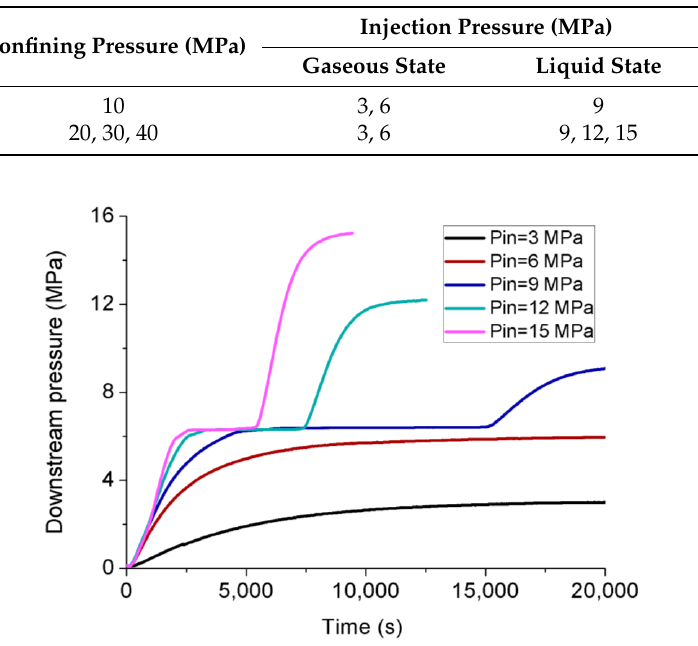
Figure 18. Measurement of downstream pressure at different CO 2 injection pressures under 20 MPa confining pressure.